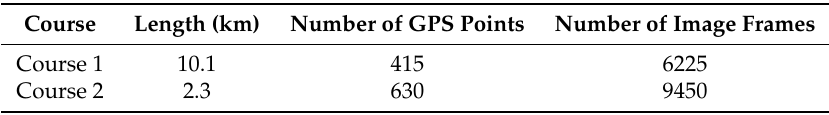
Table 1. Characteristics of experimental